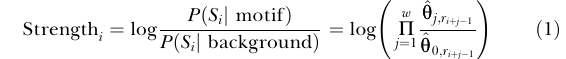
Figure S1. DNAase I Footprinting of SpoIIID Binding to the Promoters of spoIID, spoIIIA, and spoVE (A) Radioactive DNA fragments were incubated with no protein (left lane) or with 400 nM of SpoIIID protein (right lane) and then subjected to DNAaseI footprinting. A chemical sequencing ladder was used as a marker (not shown). Protected regions are indicated by a bar. (B) Position of SpoIIID-binding sites. The nucleotide sequence upstream of the transcriptional start site ( þ 1) is shown for spoIID, spoIIIA, spoVE -P1, and spoVE -P2. The boundaries of the region protected from DNAase I digestion by SpoIIID are indicated by bars. The bold letters identify the sequences within the protected regions that match with the SpoIIID consensus sequence. Figure S2. Mapping of Transcription Start Sites by 5 9 RACE–PCR The underlined uppercase bold letters identify the 5 9 ends of mRNAs from r K -controlled genes as determined by RACE–PCR. Also indicated are the corresponding (cid:1) 35 and (cid:1) 10 regions (uppercase letters in bold), the ribosome-binding site (double underlining), and the translation start site (uppercase letters). RNA collected from strain PE454 (sigE þ sigK þ ) and strain PE455 (sigE þ , sigK (cid:1) ) was used for the determination of transcription start sites. In four cases indicated with an asterisk (yfnE, yhcO, yitC, and ypqA), an identical transcription start site was identified for strains PE454 and PE455, which is interpreted as evidence that the promoters for these three tran- scription units are recognized both by r E and r K . In all of the